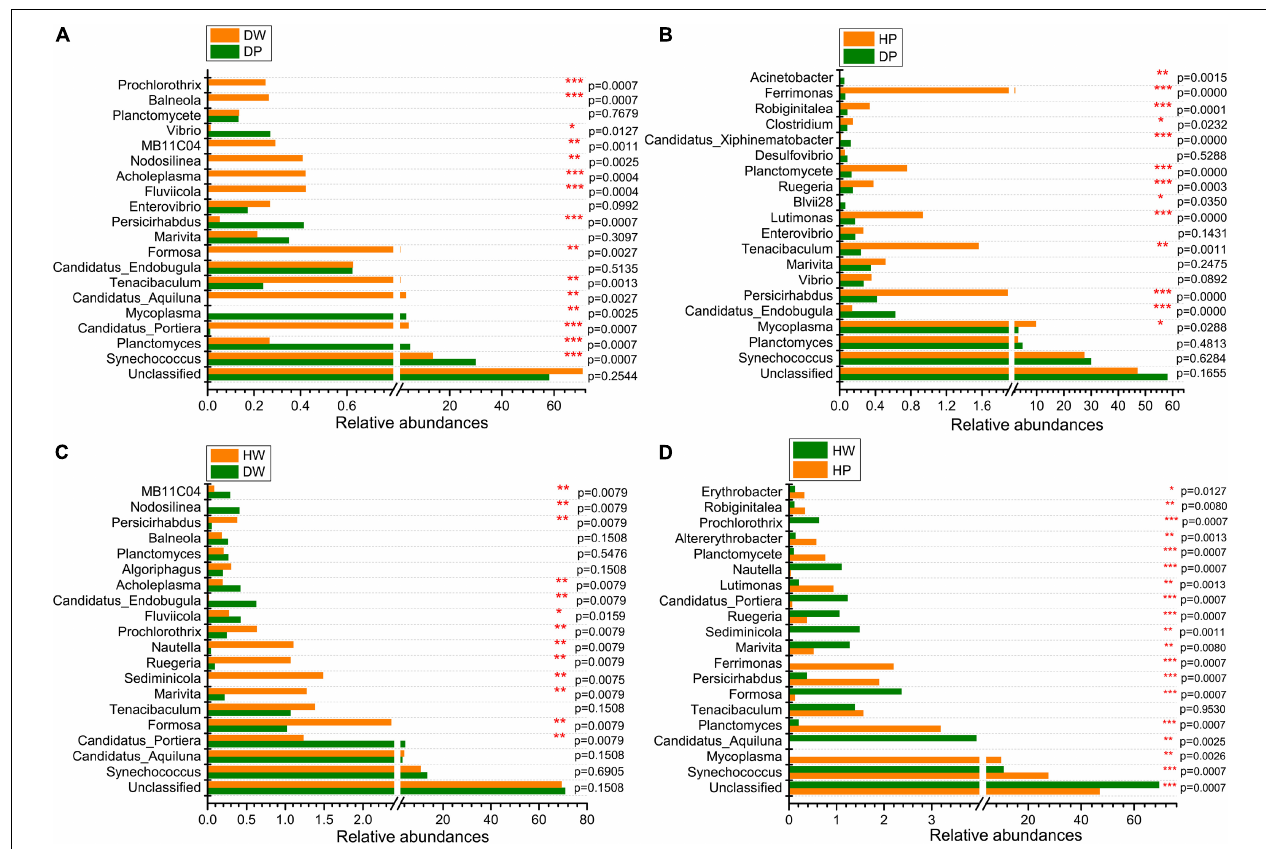
FIGURE 6 | Comparison of microbial community between DW and DP (A) , HP and DP (B) , HW and DW (C) , and HW and HP (D) at the genus level. *0.01 < p ≤ 0.05, **0.001 < p ≤ 0.01, and *** p ≤